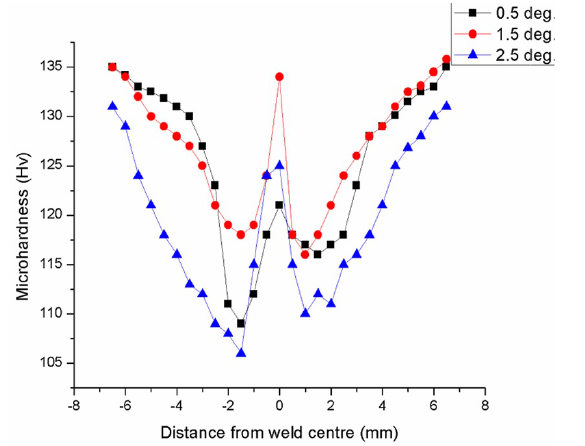
Figure 15: Effect of tilt angle on